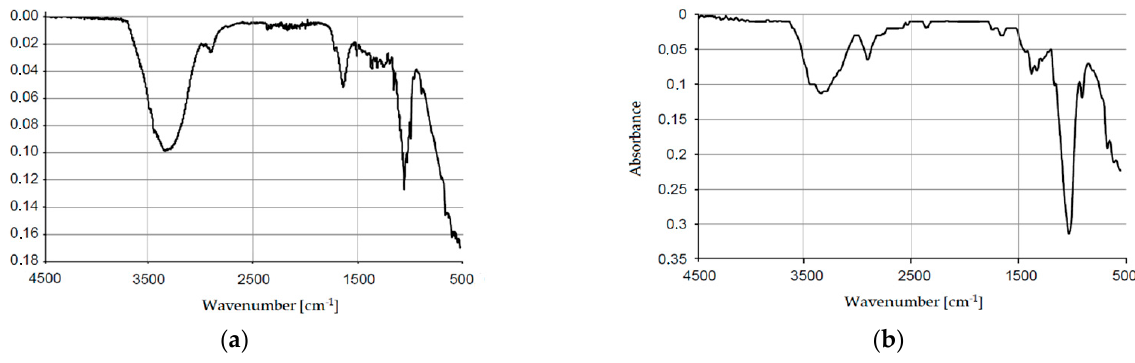
Figure 5. Results of FTIR/ATR tests: ( a ) FTIR/ATR spectrum (wet nanocellulose); ( b ) FTIR/ATR spectrum (dry nanocellulose).